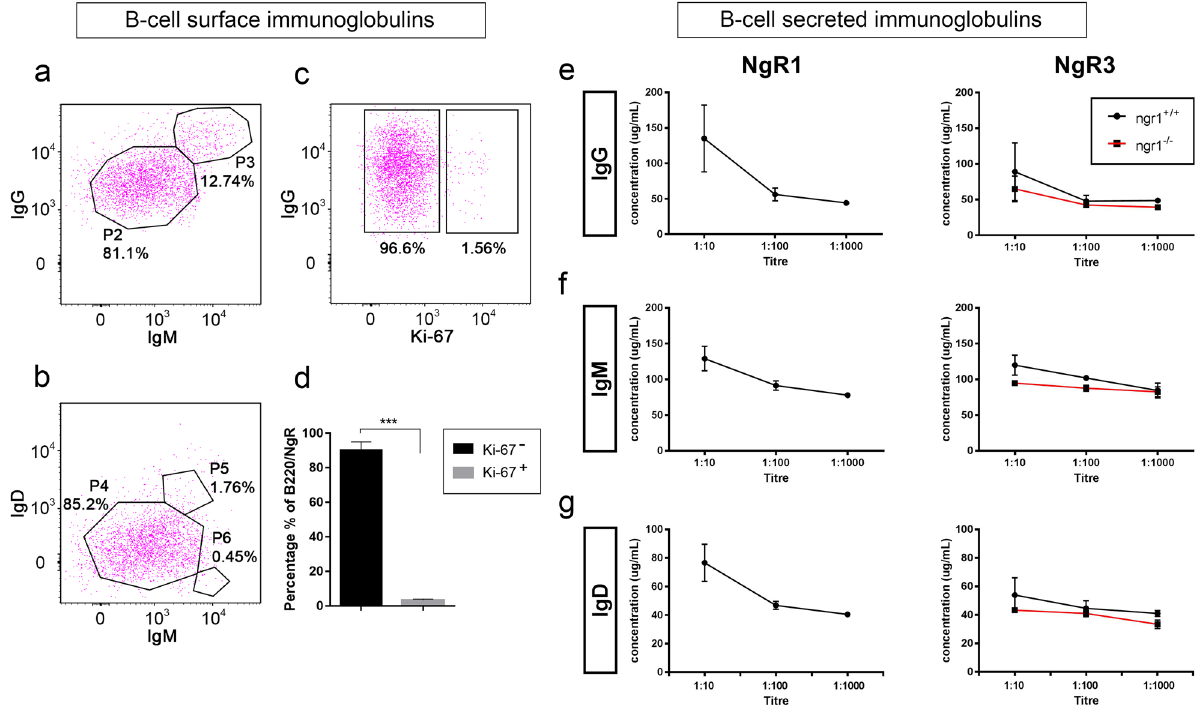
Figure 4. NgR1 + and NgR3 + B-cells exhibit increased secretion of IgG during the EAE onset. ( a ) Representative dot plots of NgR3 + B-cells isolated from both ngr1 + / + EAE-induced mice exhibited increased levels of IgG than IgM on their cell surface. ( b ) IgM + B-cells found to be more abundant in comparison to IgD + B-cell populations. ( c ) NgR1 + and NgR3 + B-cells were found to be mainly IgG + with the representative estimation of NgR3 + isolated B-cells exhibiting ~ 96.6% IgG + , when gated against the cell proliferation marker Ki-67. ( d ) The data are represented in a bar graph of multiple experiments with mean ± SEM (n = 6; t test *** p < 0.001). ( e – g ) The titers of the secreted immunoglobulins from isolated and cultured NgR1 + and NgR3 + B-cells were also evaluated from isolated supernatant samples by ELISA for both ngr1 + / + and ngr1 −/− mice. Lower titers yielded a higher concentration of the respective antibodies. ngr1 −/− mice showed a reduced capacity for production of IgG, IgM and IgD but with no statistically significant differences. Results represent mean ±